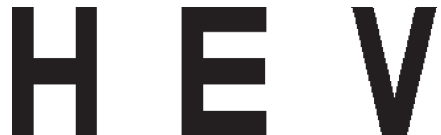
Figure 2: Black-and-white (HEV) images presented for tolerance/ sensitivity to